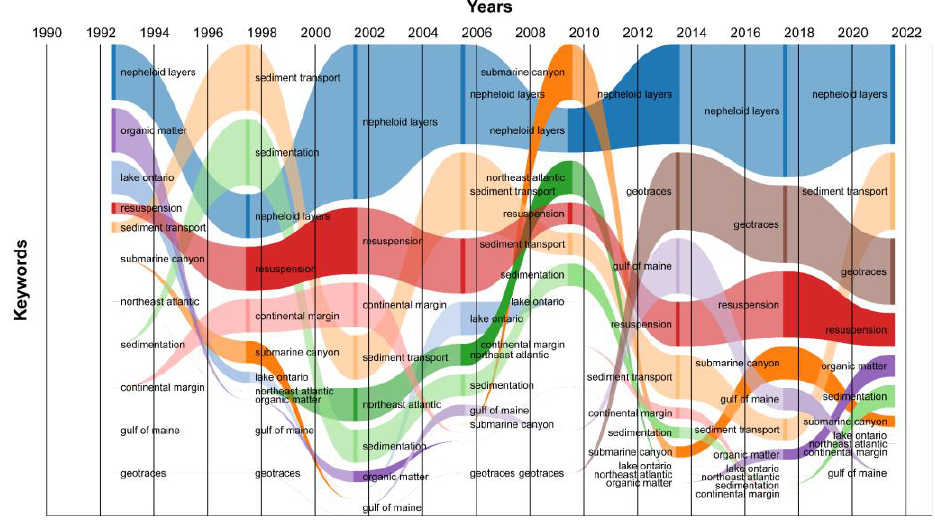
Figure 6. Top three keywords for every two years, tracking dramatic changes from 1990 to 2022. A bump graph shows the keyword’s evolution of frequency and ranking through time. The tube width depicts the average frequency of the keywords in the abstract, title, and paper.